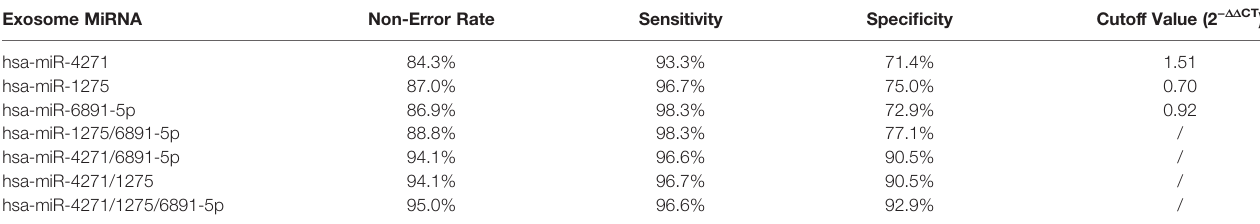
TABLE 4 | Diagnostic value analysis of serum exosome miRNAs in ICP.